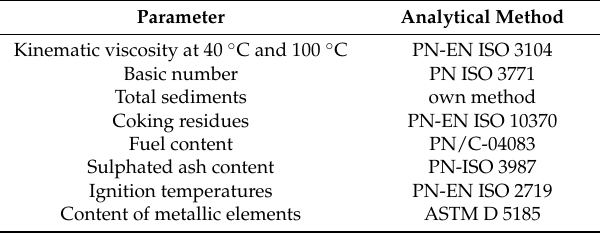
Table 1. Analytical methods used for engine oil analysis.